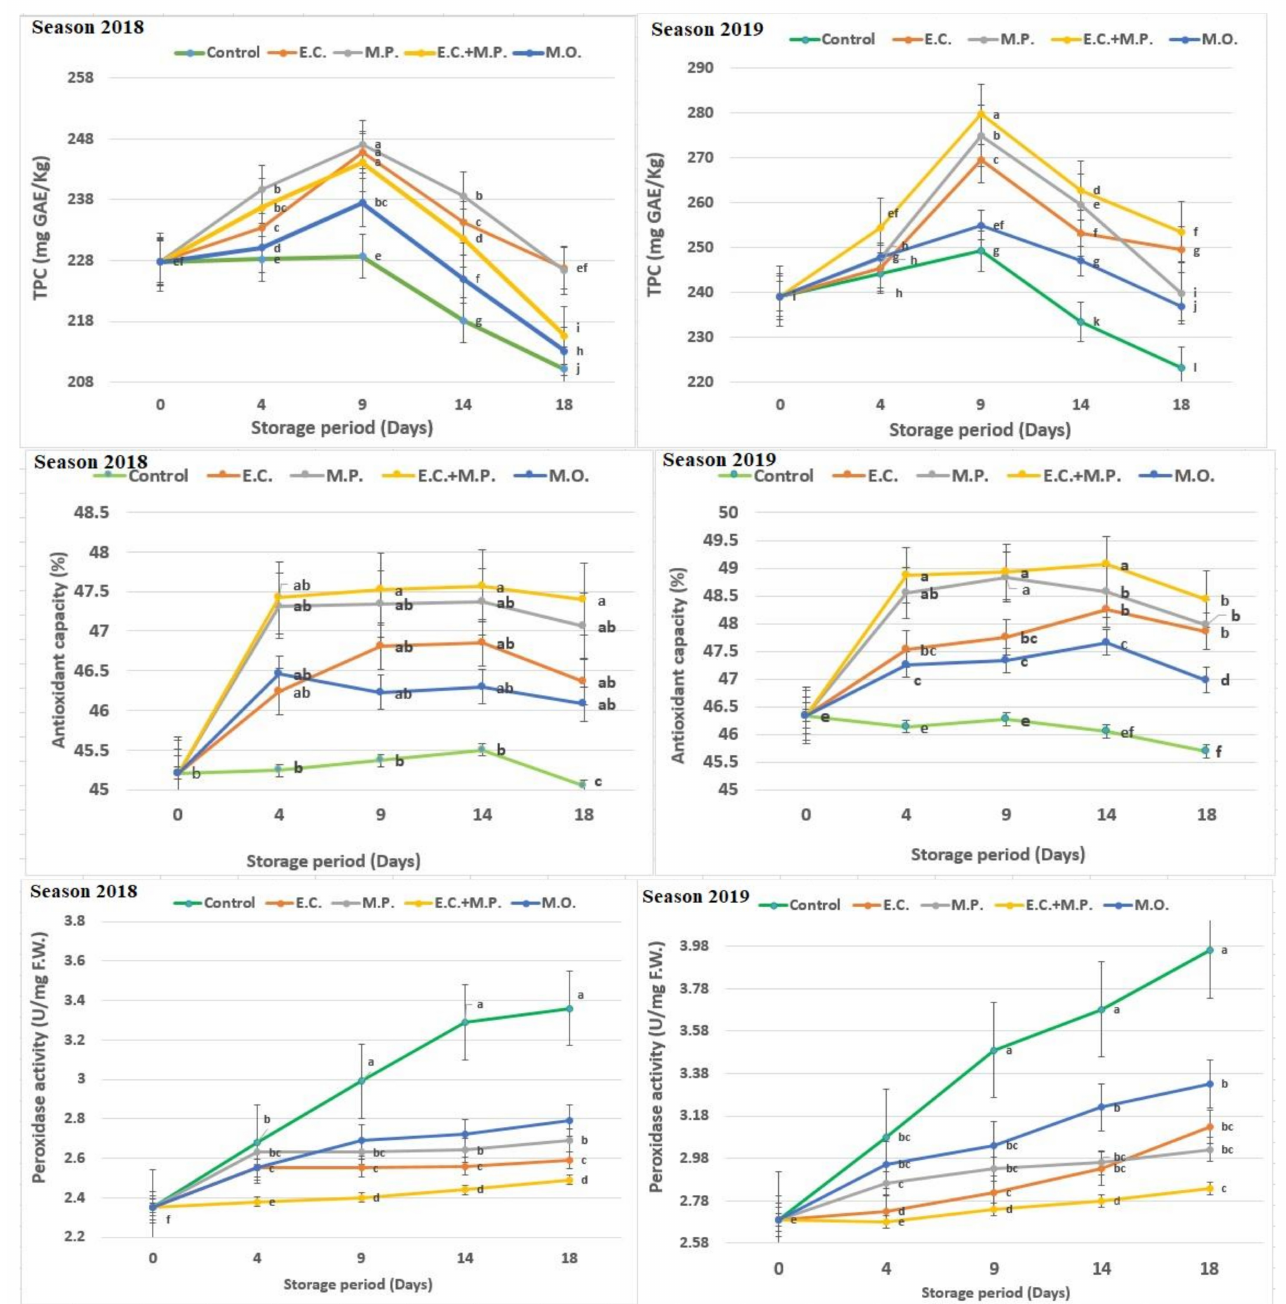
Figure 1. Visual and chemical parameters (means ± S.E) of strawberry fruits stored at 5 ◦ C as affected by the application of natural oils at different storage durations in both seasons 2018 and 2019. Fruits treated with Control: without oils; E.C.: E. camaldulensis var obtusa EO; M.P.: M. piperita EO; E.C.+ M.P.: mix of E. camaldulensis var obtusa and M. piperita EOs (1/1 v / v ); Oil 4: M. oleifera FO. Letters (a-l) in figures explain that, means ± S.E of treatments with the same letter/s are not significant difference according to Duncan multiple range test for p <